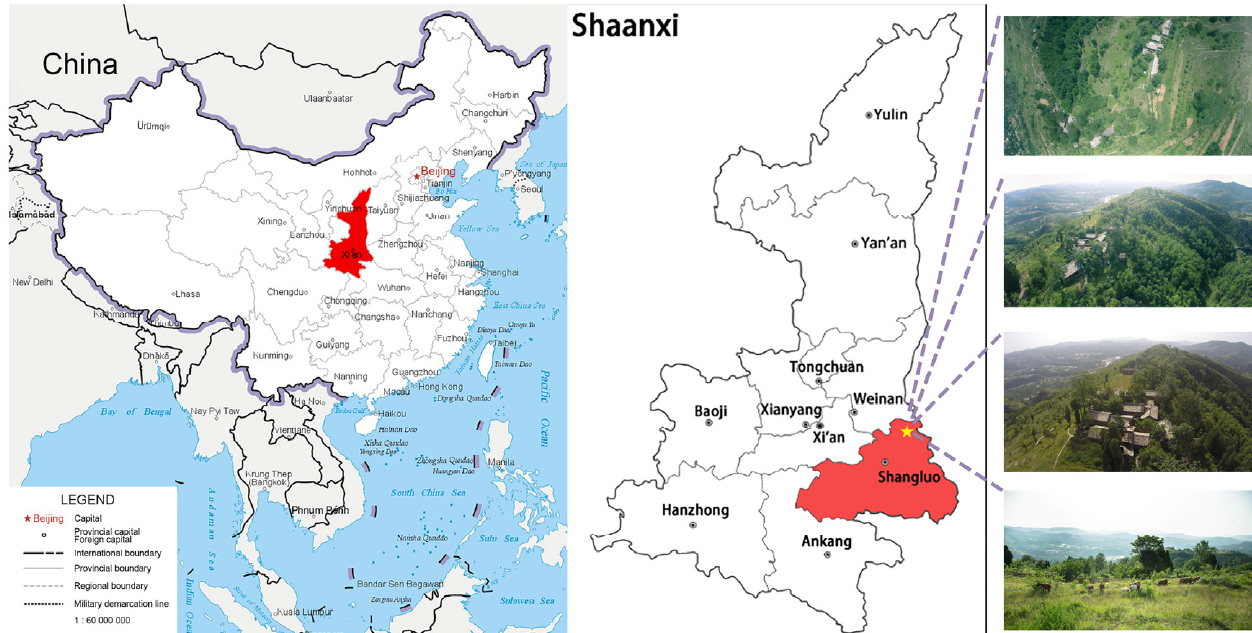
Figure 1. The location and the environment of slate dwellings in China.